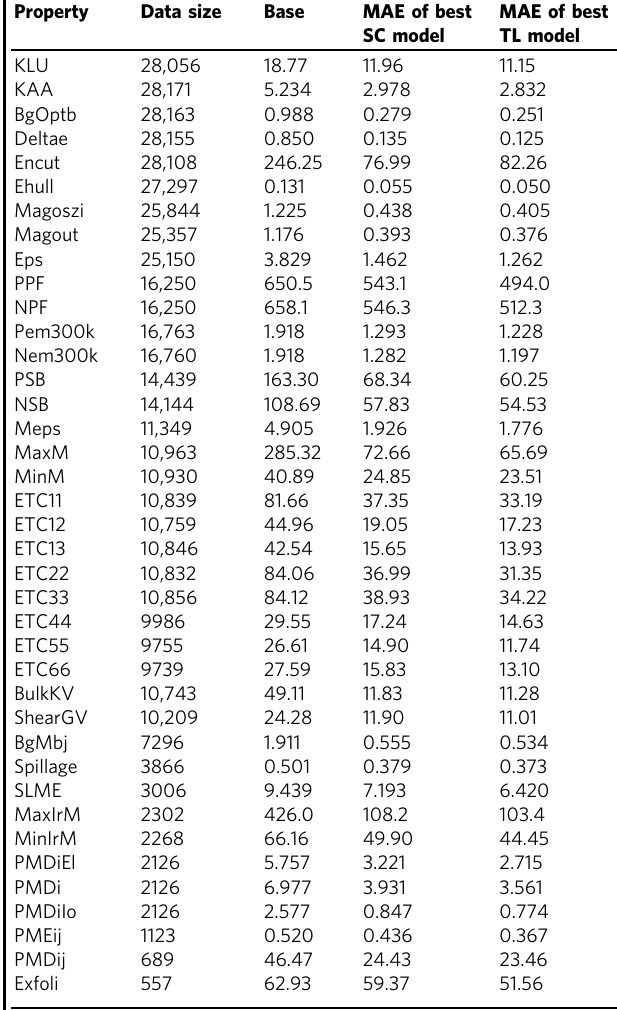
Table 2 Prediction performance benchmarking for the prediction task of “ Multi Target Transfer Learning" on the test